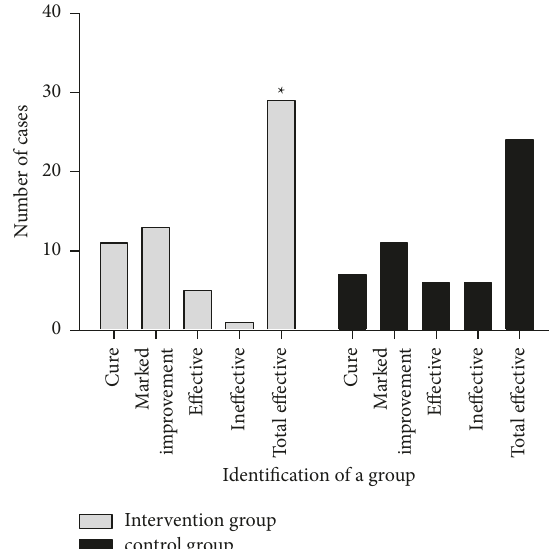
Figure 1: Comparison of recent intervention effects between the two groups. (Note: compared with the control group, ∗ P < 0 . 05).